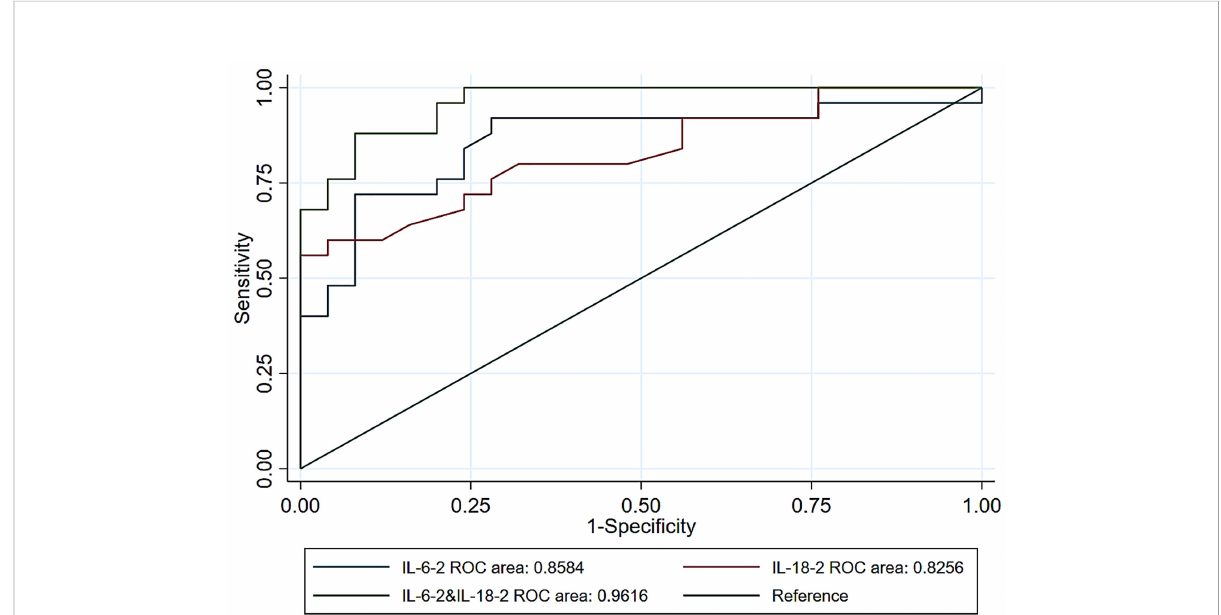
FIGURE 3 Receiver operating characteristic curves for postoperative infection prediction using IL-6 levels alone or IL-18 levels alone, and IL-6 combined with IL-18 levels at POD1. IL, interleukin; POD1, 0-hour post-operation; ROC, receiver operating